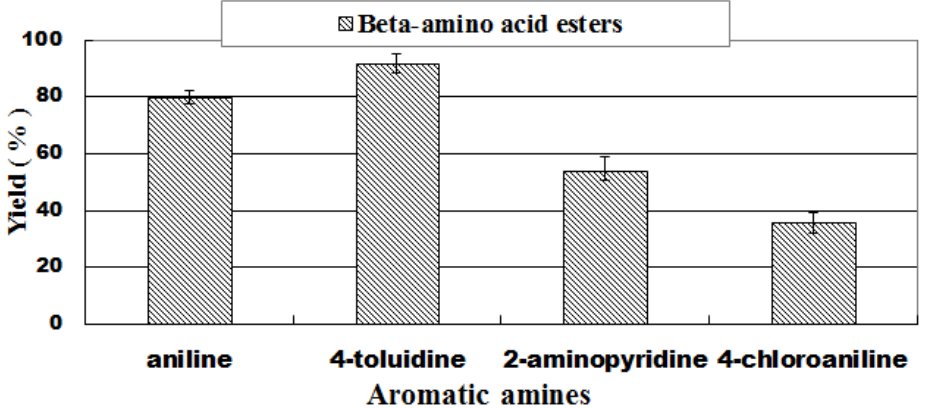
Figure 6. The effect of aromatic amine structure on enzymatic synthesis of β -amino acid esters in continuous-flow microreactors.